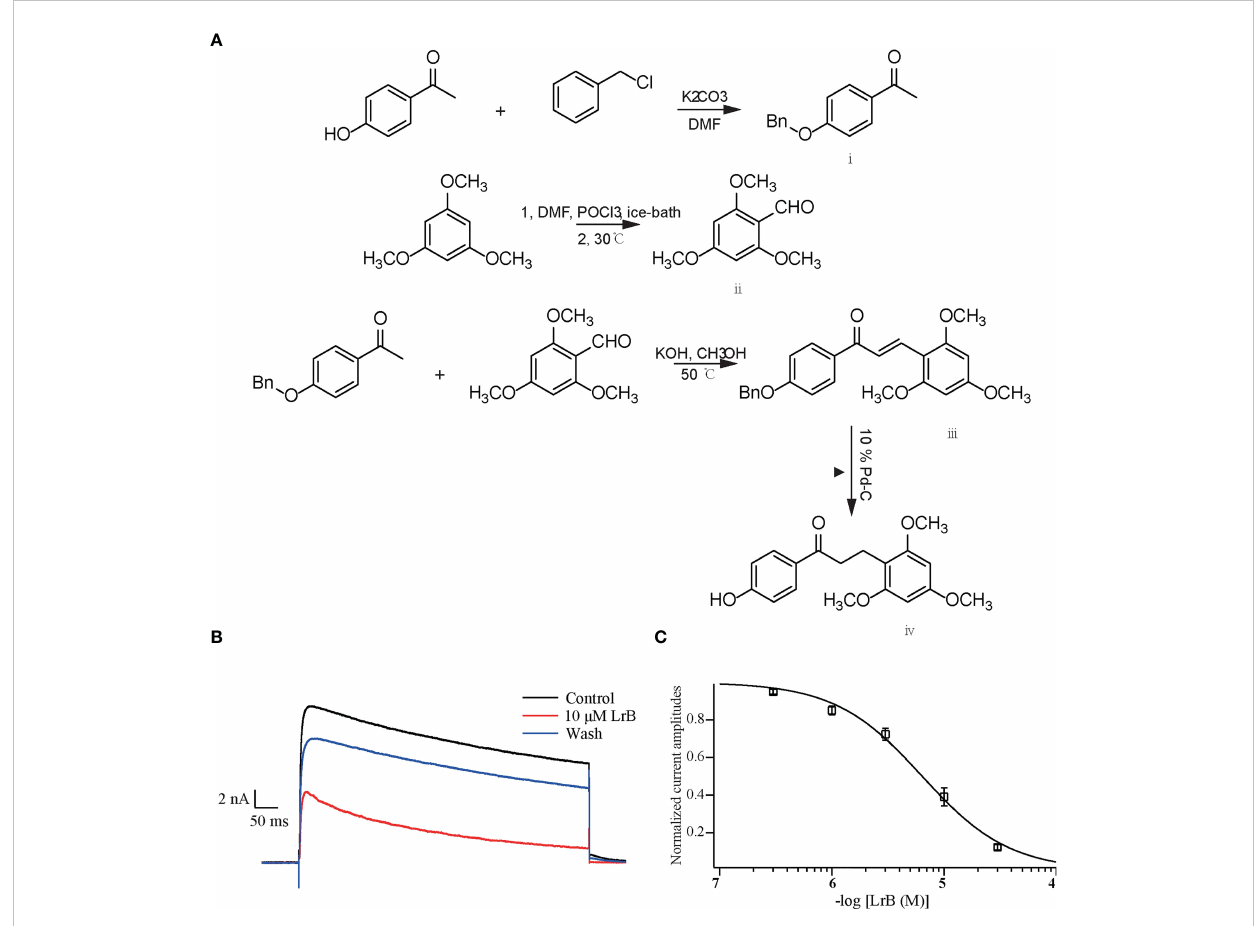
FIGURE 1 Synthetic LrB inhibited Kv1.3 currents. (A) Synthetic pathway of LrB. (B) Representative traces of Kv1.3 current in HEK293T cells in the Control, 10 m M LrB and Wash treatments. (C) Concentration-response curve of LrB inhibition of the Kv1.3 channel (n = 5, mean ±